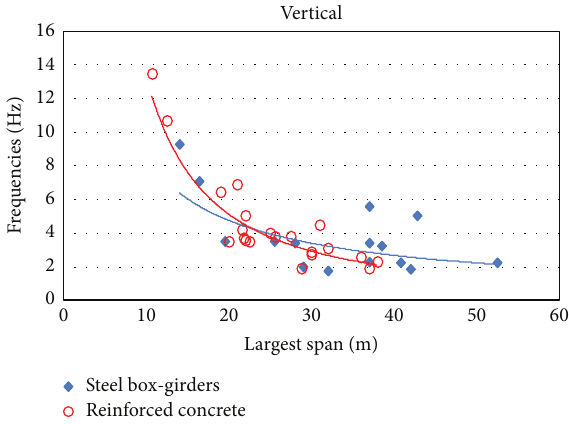
Figure 5: Comparison of frequencies for steel box-girders and RC footbridges.